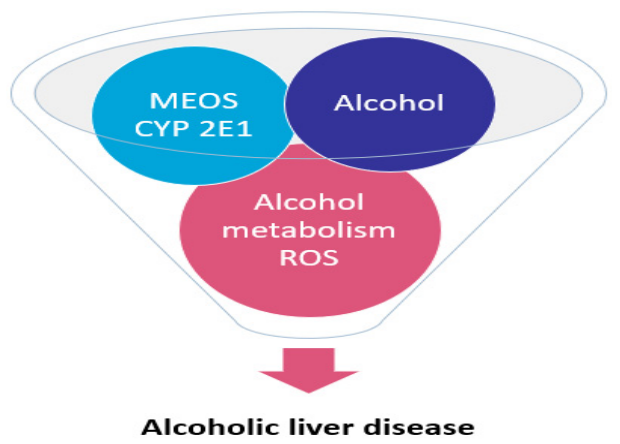
Figure 4. Co-triggering role of MEOS, CYP 2E1, and ROS in alcoholic liver disease.